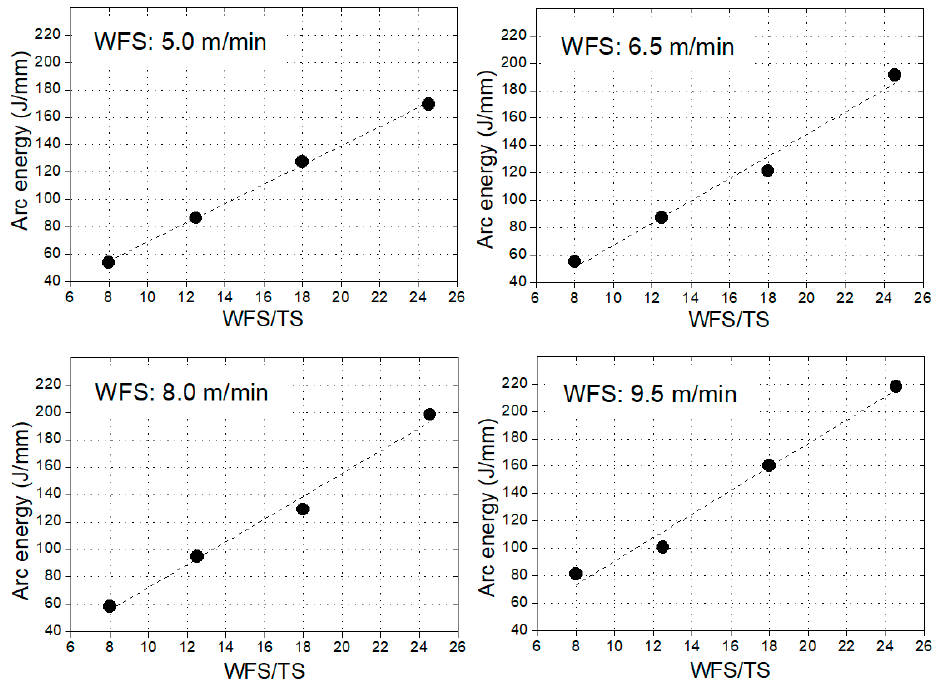
Figure 6. Correlation between the WFS/TS ratio and the arc energy per unit length of deposit for the CMT process. The WTS/TS ratio (X axis) is dimensionless, and to calculate it, the WFS and TS values must be in the same